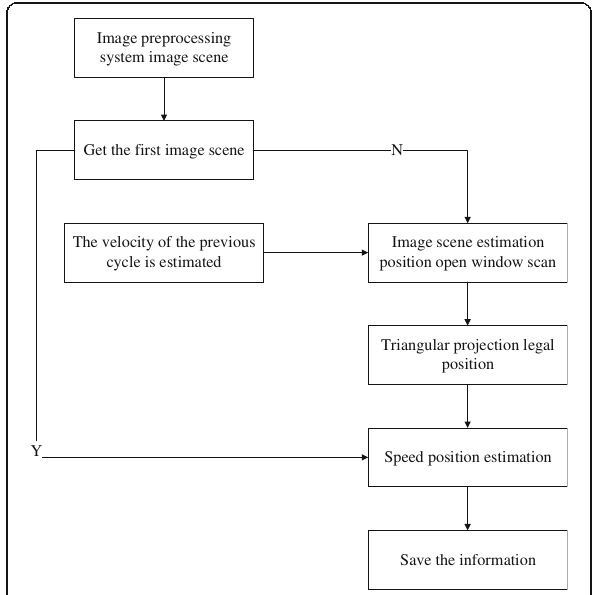
Fig. 9 Flowchart of location estimation tracking